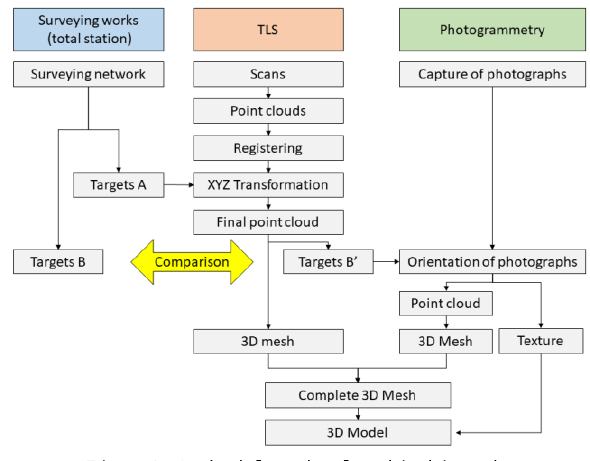
Figure 3. Methodology developed in this study.